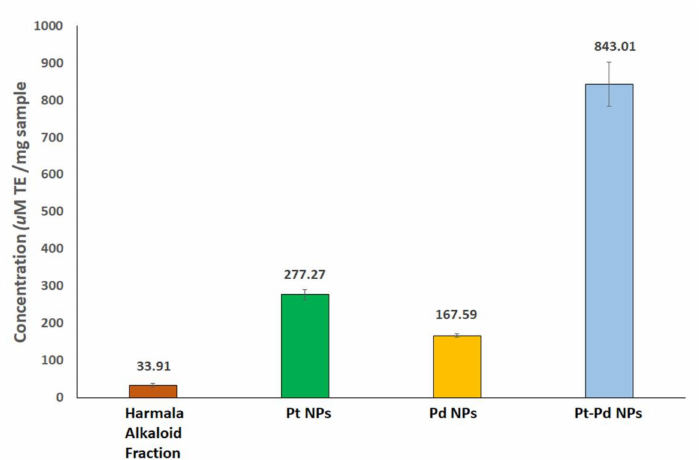
Figure 6. Ferric-reducing antioxidant power (FRAP) assay values for Pt NPs, Pd NPs, and Pt–PdNPs synthesized by P. harmala seed alkaloid fraction compared to alkaloid-rich fraction of harmala seed extract (adjusted to the content of the organic material in the NPs, 44.24%). Antioxidant activity is expressed with reference to Trolox standard as µ M Trolox equivalent (TE)/mg samples. All trials were conducted in triplicates, and data are presented as mean ± standard